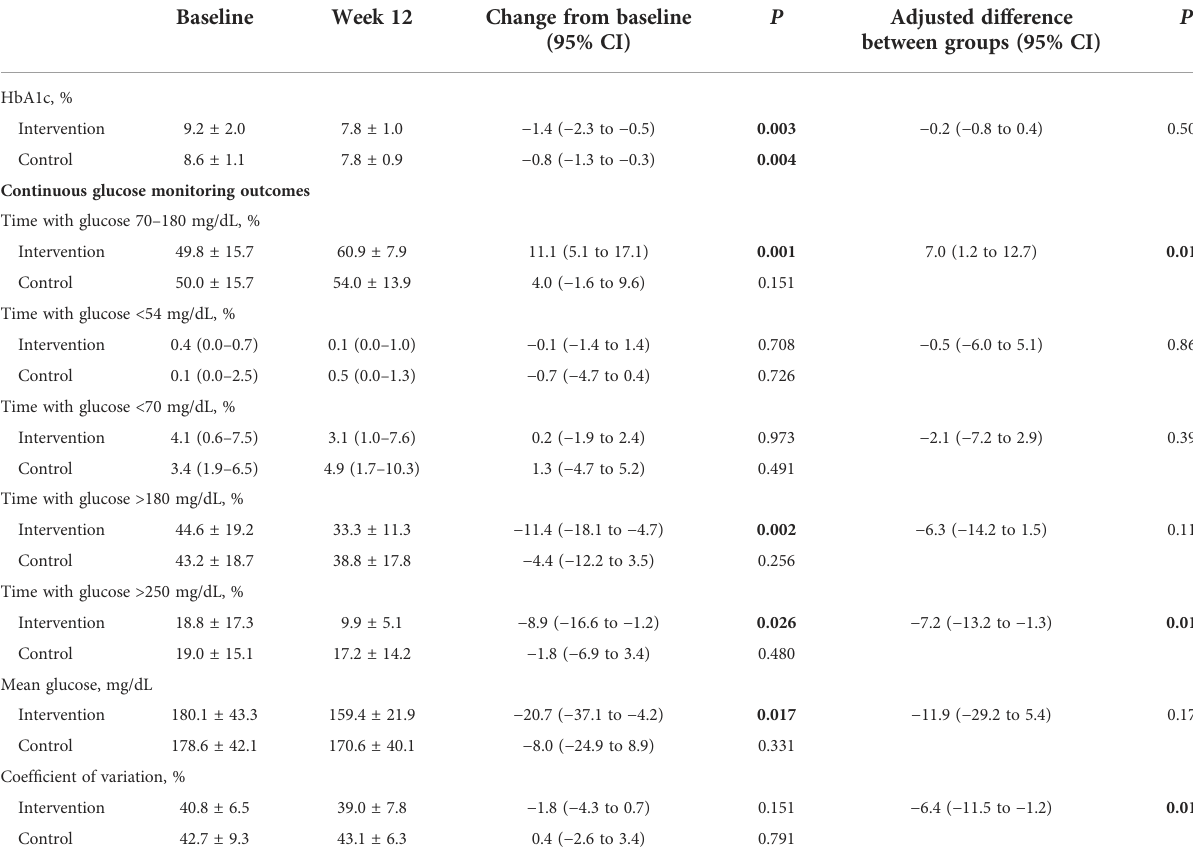
TABLE 2 Changes in HbA1c levels and continuous glucose monitoring